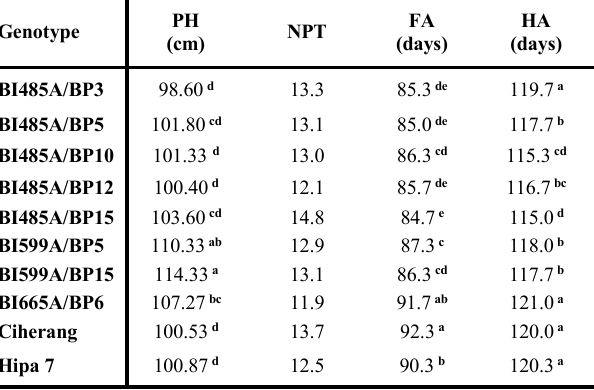
Table 3: Growth components including plant height (PH), number of productive tillers (NPT), flowering age at